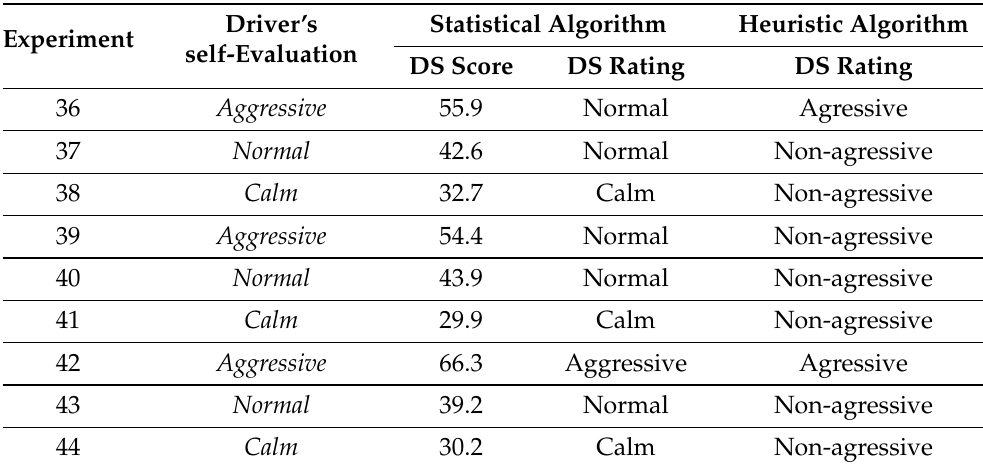
Table 4. Driving style